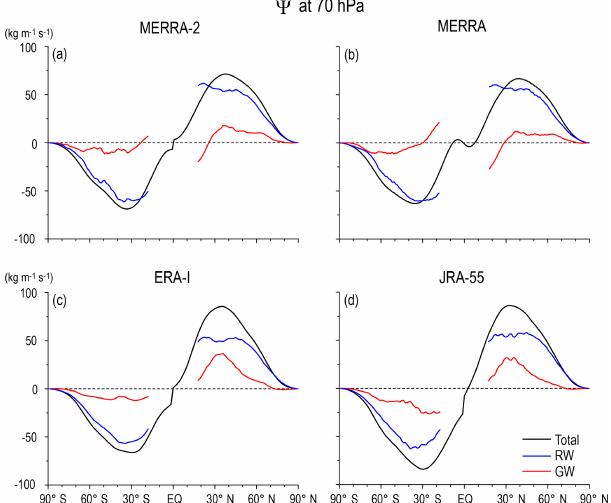
Figure 5. The same as Fig. 3 but for